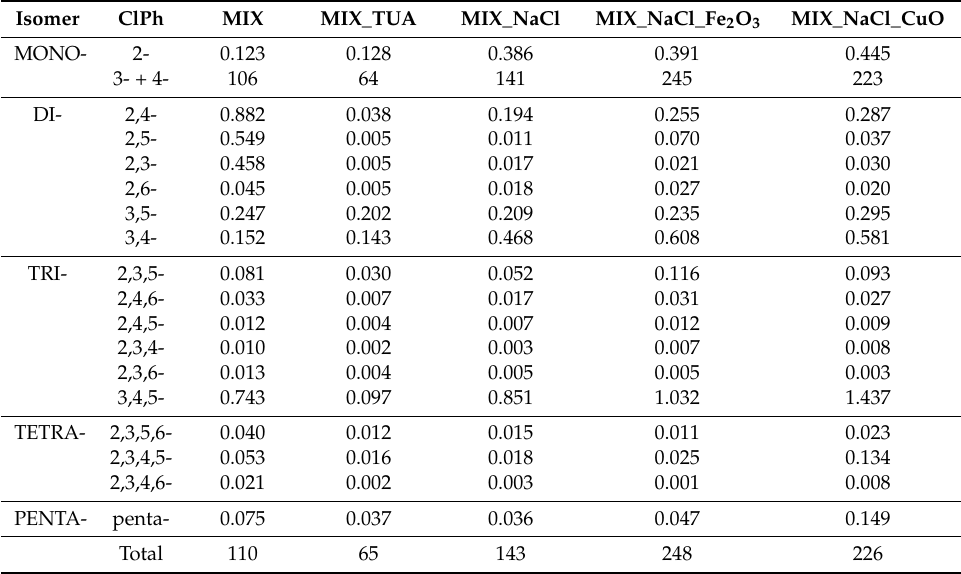
Table 3. Emissions of chlorophenols (ClPhs) during the combustion process at 850 ◦ C (mg/kg sample). Each run was duplicated ( n = 2) and average values are